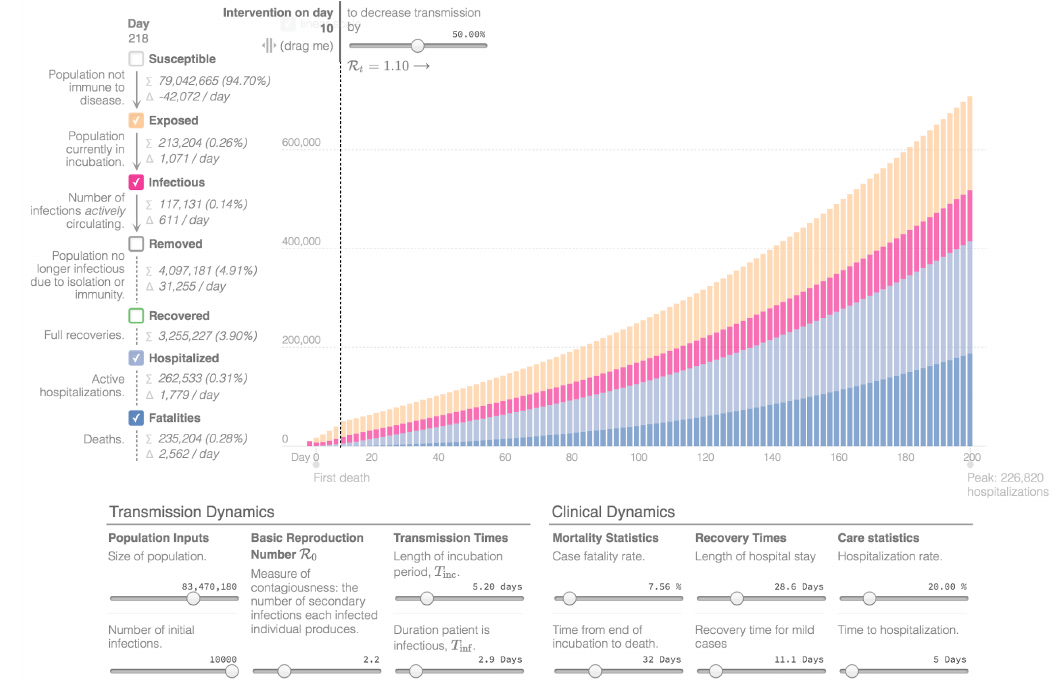
Figure 5. Epidemiological Curve 3 [7].